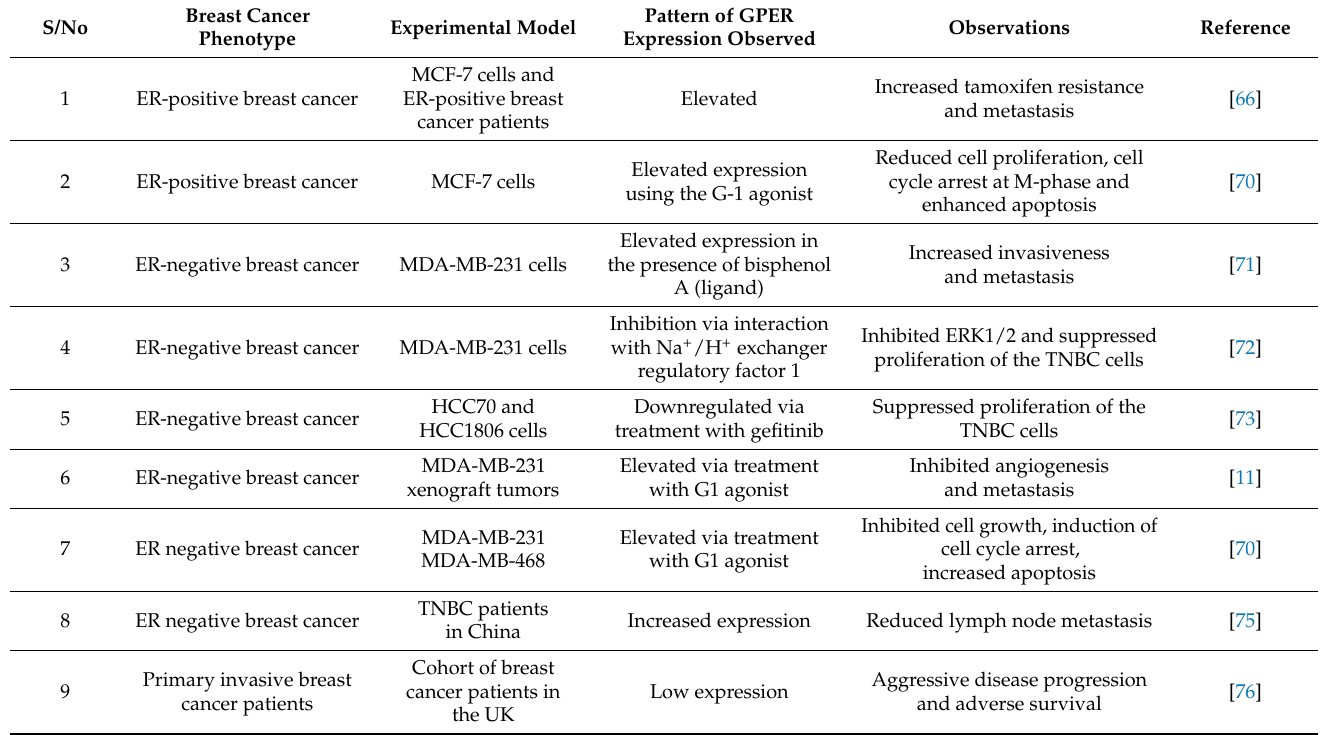
Table 1. Pattern of GPER Expression Observed in Different Breast Cancer